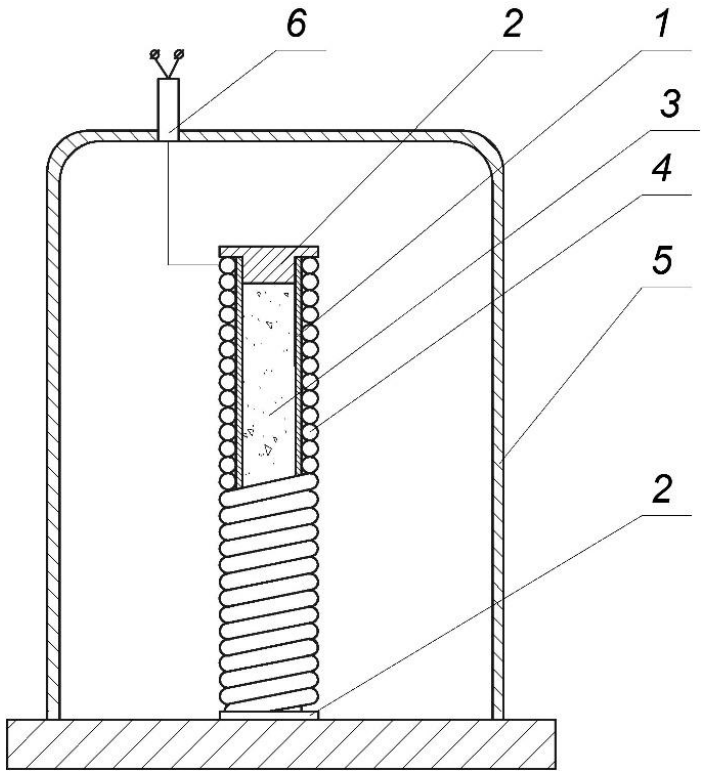
Figure 1. Scheme of obtaining the master alloy. 1 — aluminum tube, 2 — plug, 3 — powder mixture, 4 — detonating cord, 5 — chamber wall, 6 — electric detonator.